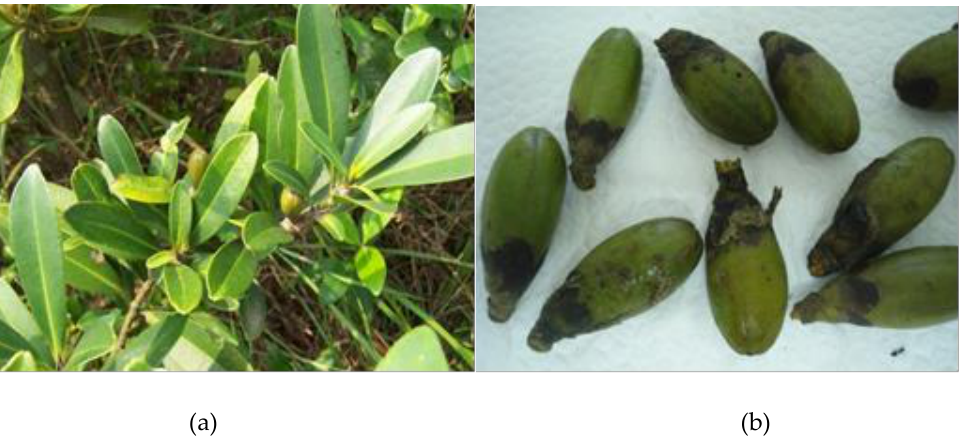
Figure 1. ( a ) The trees of Gordonia axillaris ; ( b ) The fruits of Gordonia axillaris .